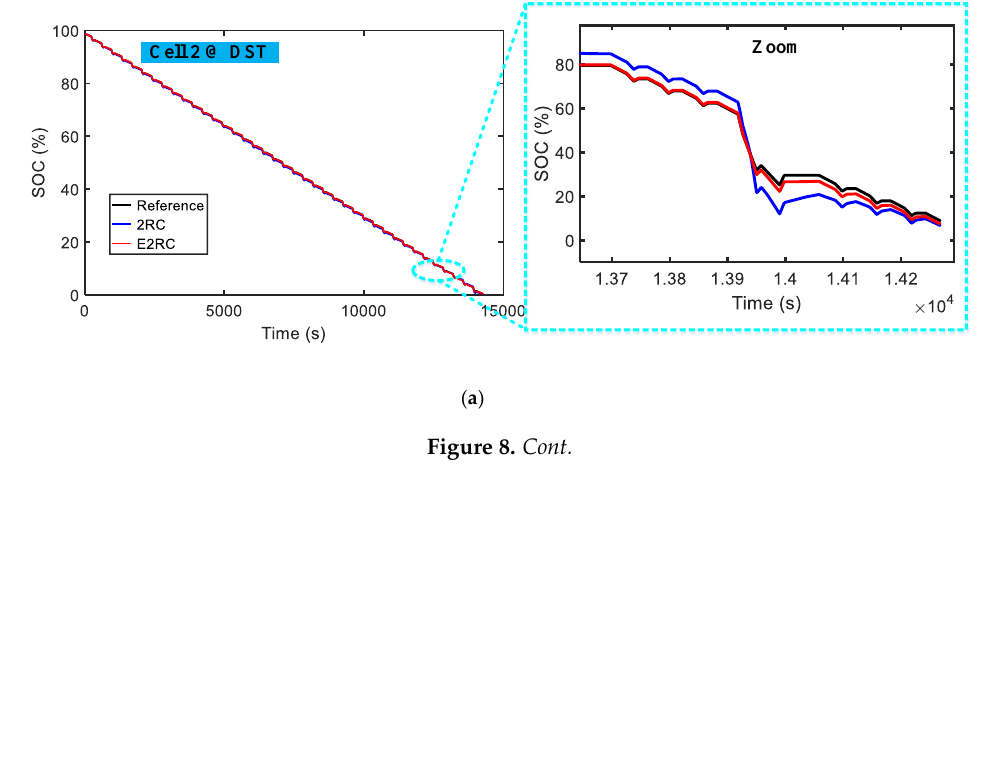
Figure 7. State-of-charge (SOC) estimation results under NEDC working condition. ( a ) SOC estimated value; ( b ) SOC error.